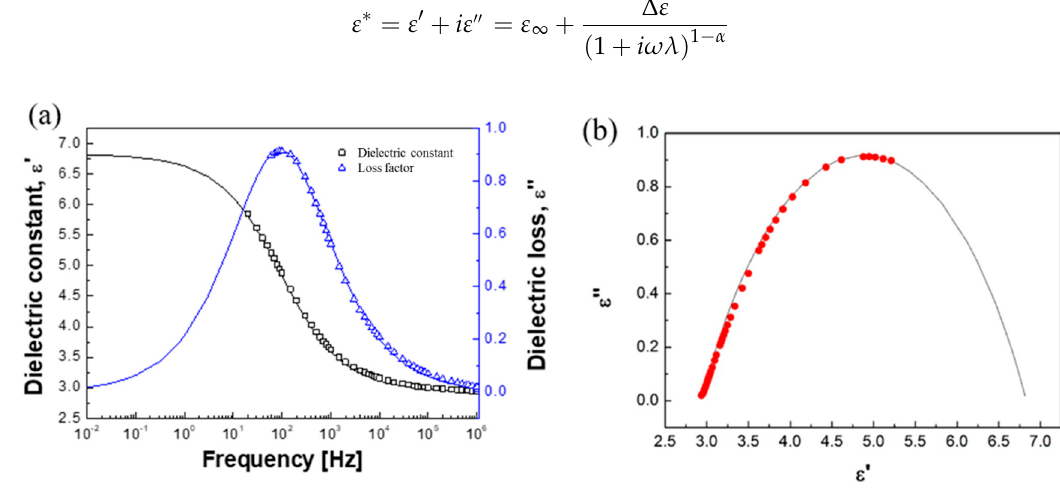
Figure 15. ( a ) Dielectric spectrum and ( b ) Cole–Cole plot of silica/POA based ER suspension, with permission from [82]. Copyright IOP Publishing, reprinted with permission from [82]. Copyright IOP Publishing, 2017.